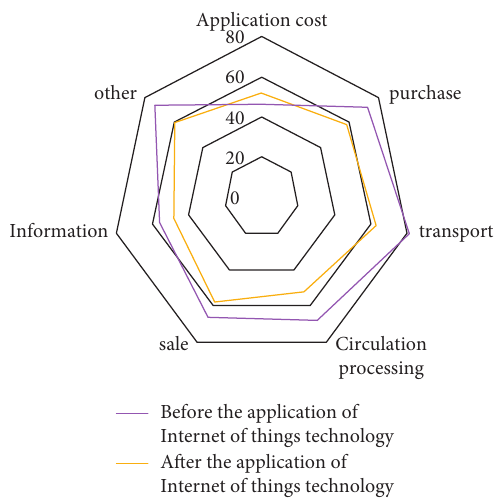
Figure 8: Competitiveness of subindicators in supply chain business process dimension.